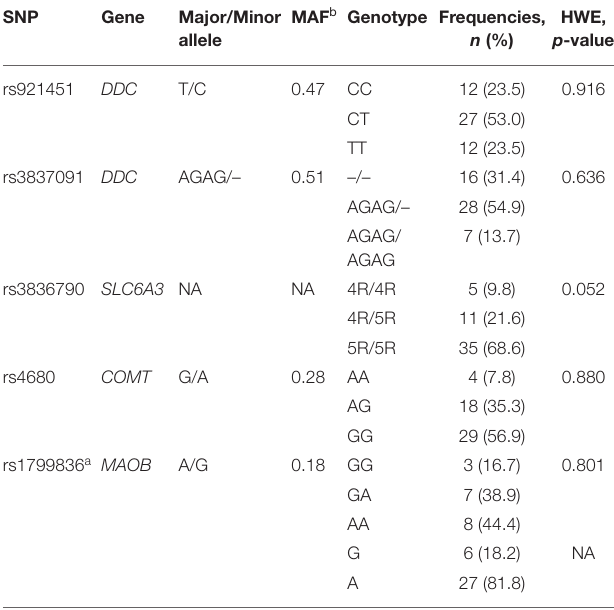
TABLE 1 | SNP genotype distributions.